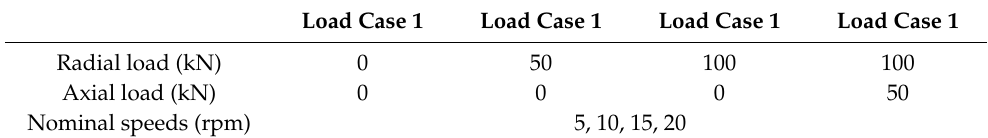
Table 4. Test conditions.